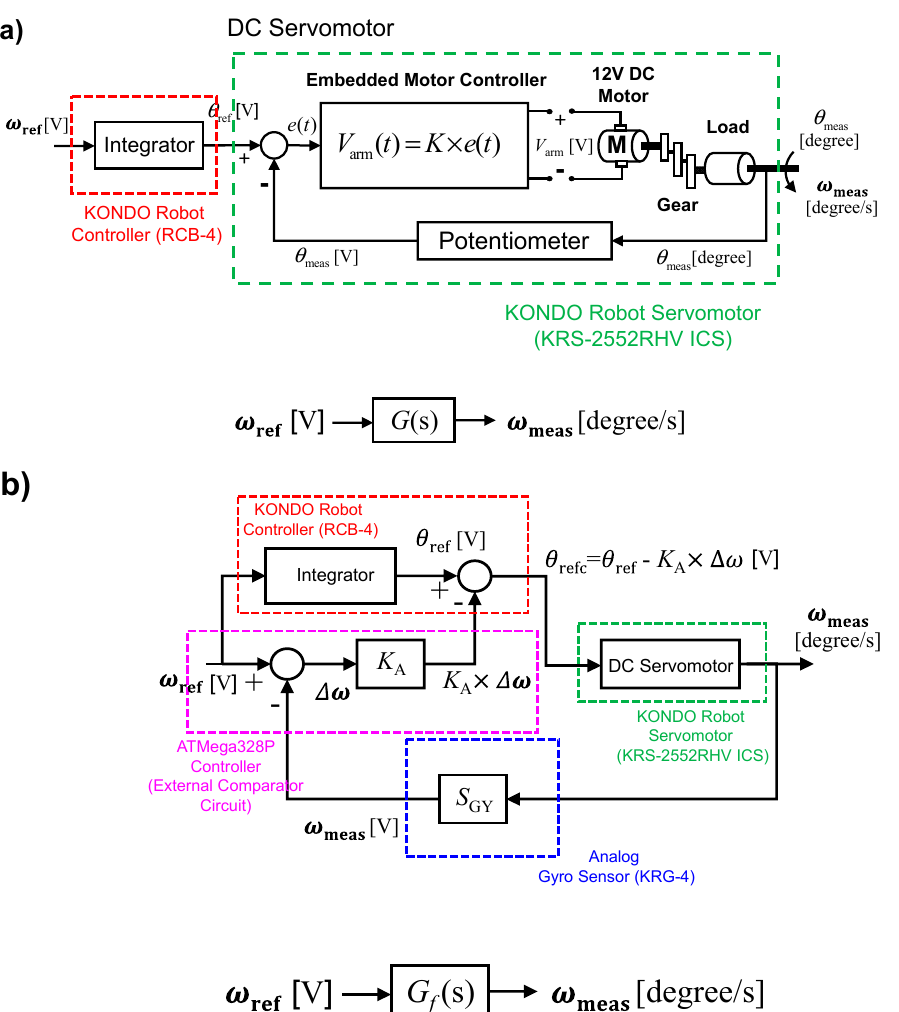
Figure 4. ( a ) Schematic diagram of the internal control circuit of DC servomotor used in the experiment. The transfer-function formulation used for modeling the motor-control system without the gyro-sensor feedback loop. ( b ) Schematic diagram of the motor-control system, implemented for adjusting the robot’s ankle-pitch motor on inclined surfaces. The difference Δω between measured angular-pitch velocity and a reference angular-pitch velocity, stored in the robot’s control system, is amplified by factor K A for feedback to the ankle-pitch motor.